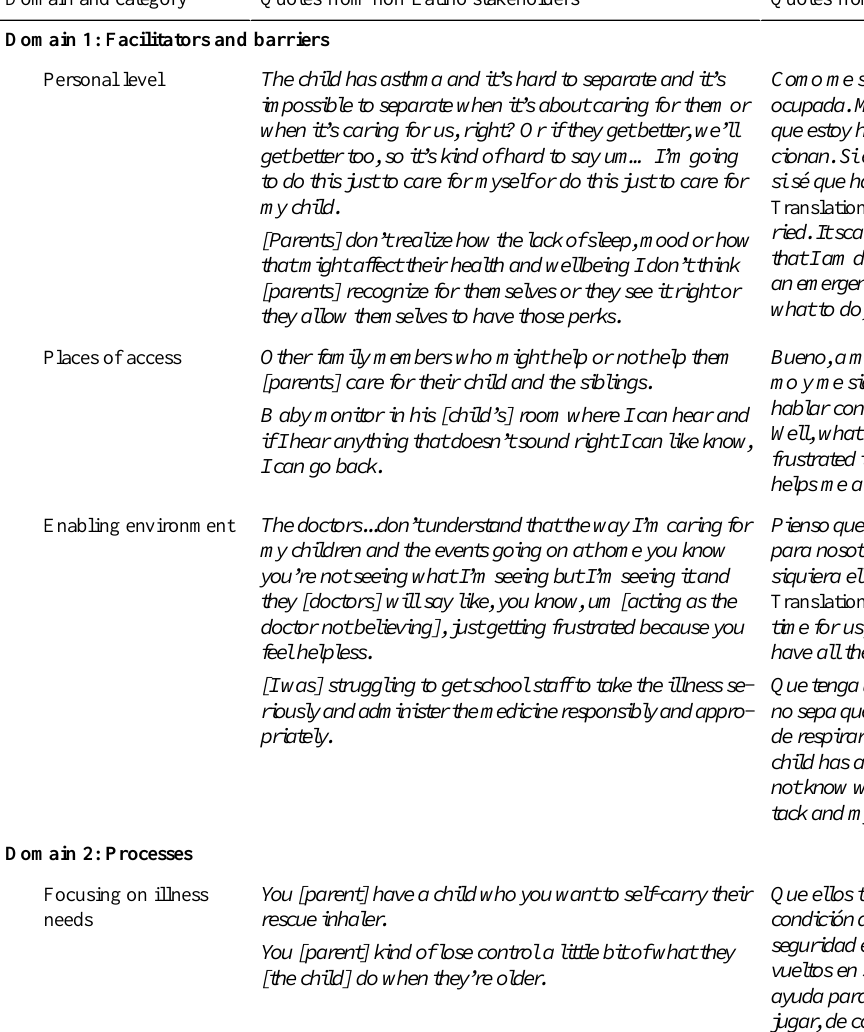
Quotes from Latino stakeholdersQuotes from non-Latino stakeholdersDomain and category